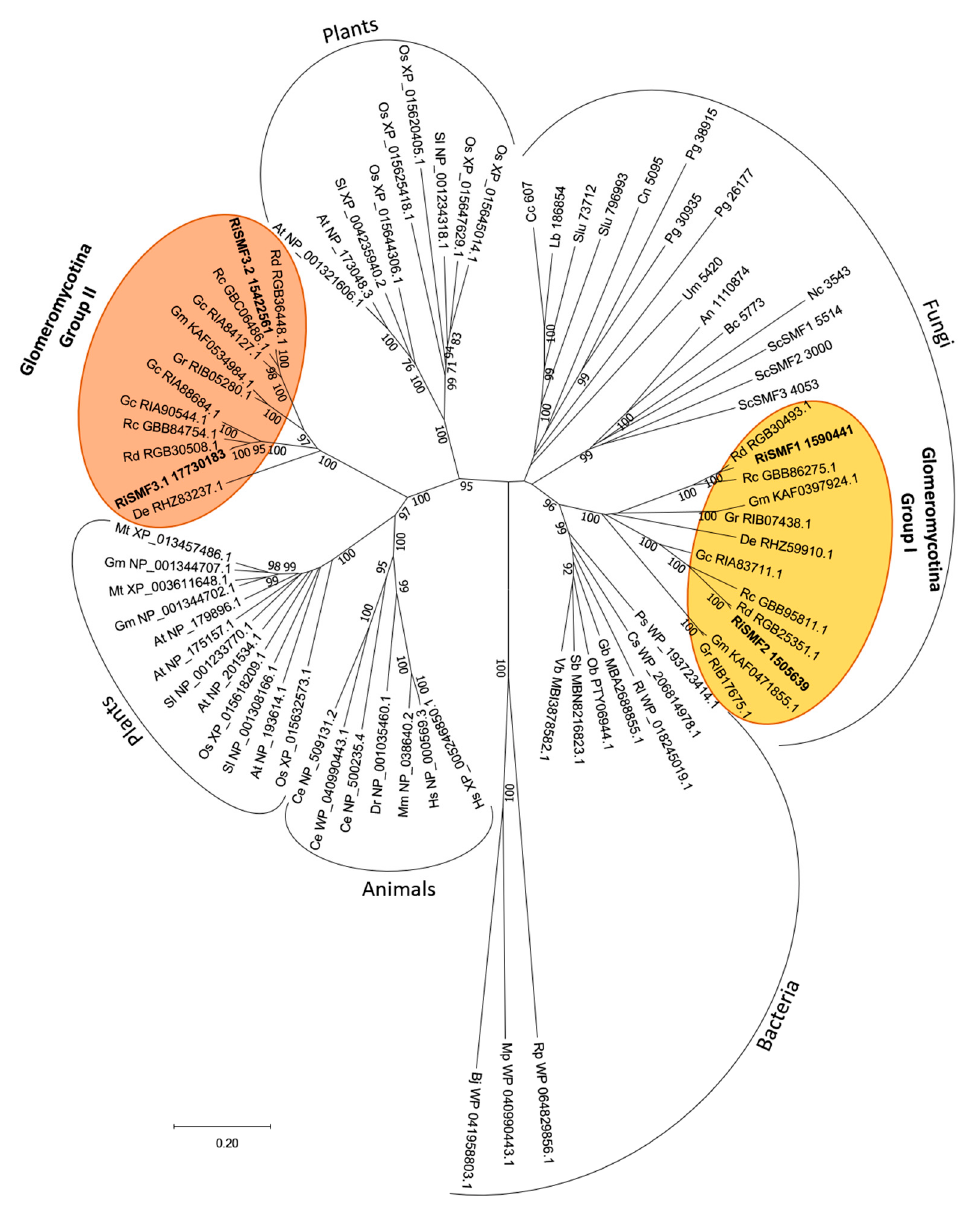
Figure 2. Phylogenetic relationships of the R. irregularis NRAMP proteins, with homologous se- quences from selected species representative of the different kingdoms. The yellow and orange circles indicate the Glomeromycotan Group I and Group II sequences, respectively. The neigh-